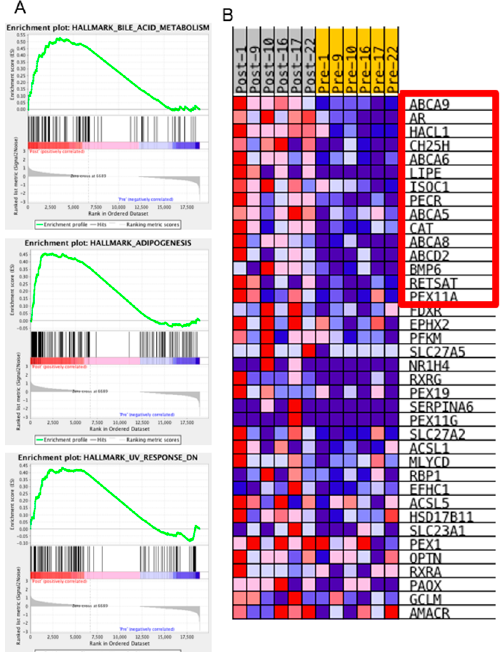
Figure 5. GSEA Post-NACT enrichment plot for genes related to bile acid metabolism. Gene sets enriched for genes upregulated in post-NACT samples based on GSEA analysis. ( A ) Post-NACT enrichment plots for the three significantly enriched Hallmark gene sets, Bile Acid Metabolism, Adipogenesis and UV response down ( p < 0.01 based on comparison to ESnull dataset, see methods). ( B ) Heatmap of the 38 genes contributing to bile acid metabolism GSEA enrichment plot. A red box is drawn around the top 15 upregulated genes. Table 4. Hallmark gene sets enriched in post-NACT samples.